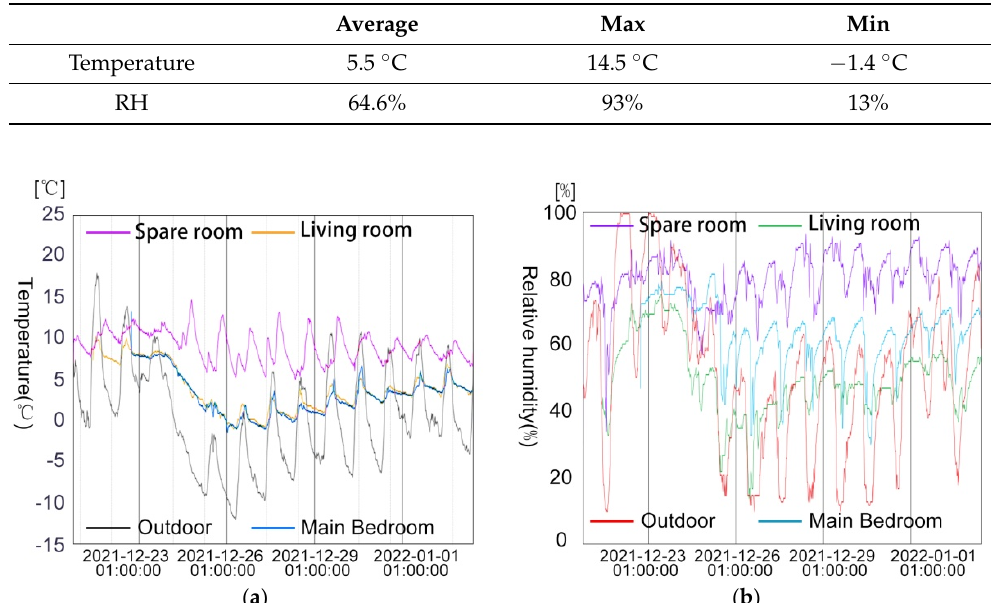
Figure 20. Distribution of indoor environmental parameters of W3: ( a ) air temperature; ( b ) relative